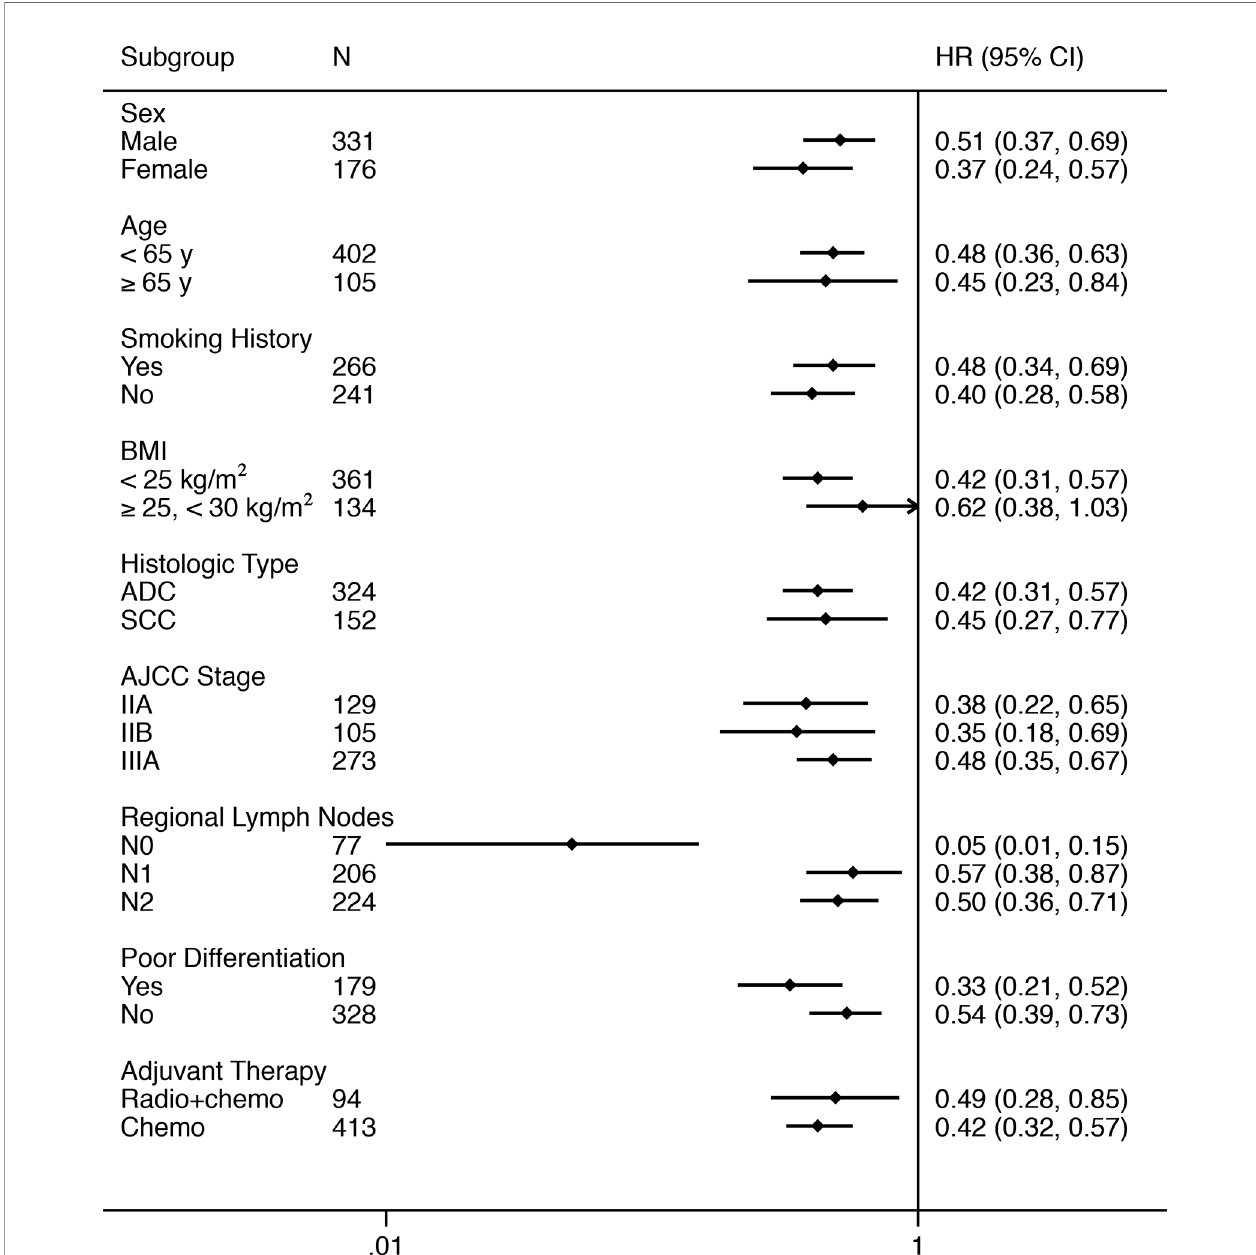
FIGURE 2 | Forest Plot of the Treatment Effect on Disease-free Survival in Subgroup Analyses. BMI, body mass index (calculated as weight in kilograms divided by height in meters squared); ADC, adenocarcinoma; SCC, squamous cell carcinoma; AJCC, American Joint Committee on Cancer; Radio, radiotherapy; Chemo,